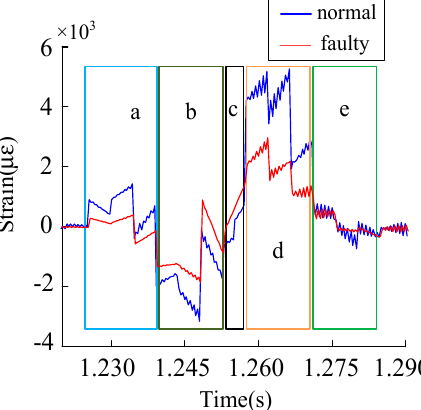
Figure 20. Enlarged view of the partial meshing deformation zone.